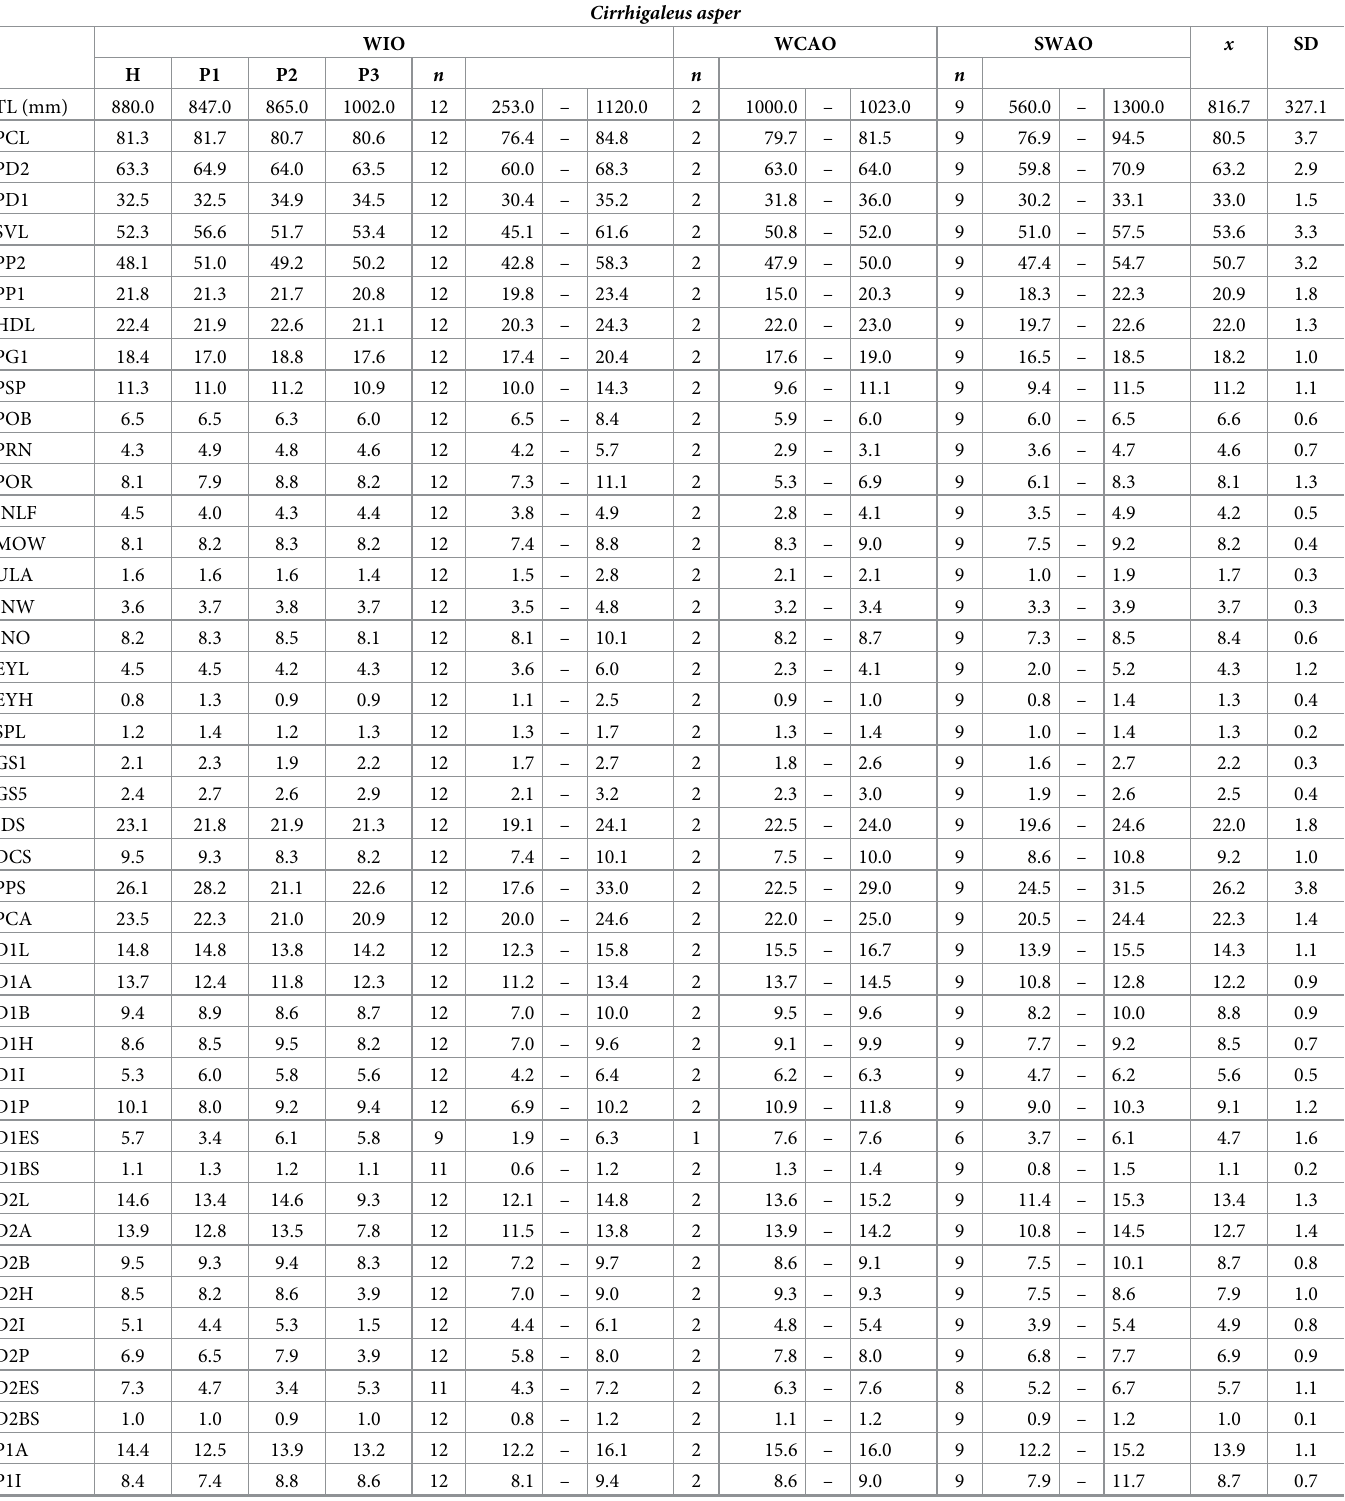
Table 2. External measurements of C . asper expressed as percentage of total length